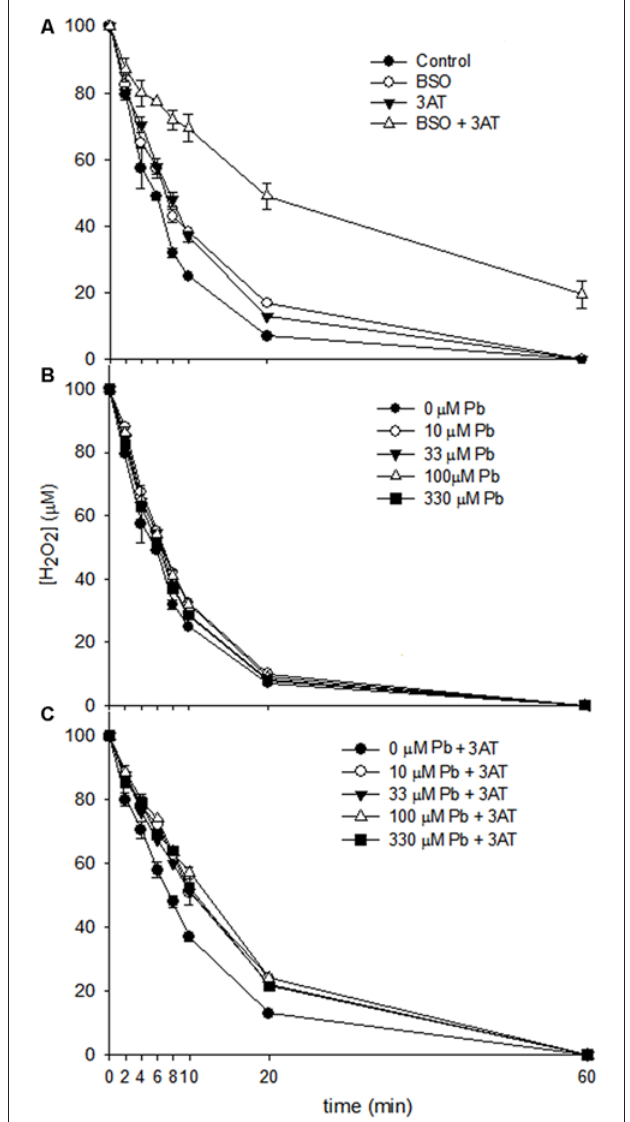
FIGURE 3 | Clearance of H 2 O 2 by rat astrocyte cultures. Cells were incubated for 60 min with 500 µ l of 100 µ M H 2 O 2 , and media were collected at the specified time points for measurement of H 2 O 2 concentration. (A) Dulbecco’s modified eagle medium (DMEM) only control, 1 mM Buthionine sulfoximine (BSO), 10 mM 3AT or 1 mM BSO + 10 mM 3AT. (B) 10–330 µ M lead acetate. (C) 10–330 µ M lead acetate + 10 mM 3AT. Each data point represents mean ± SD of n = 9 samples.